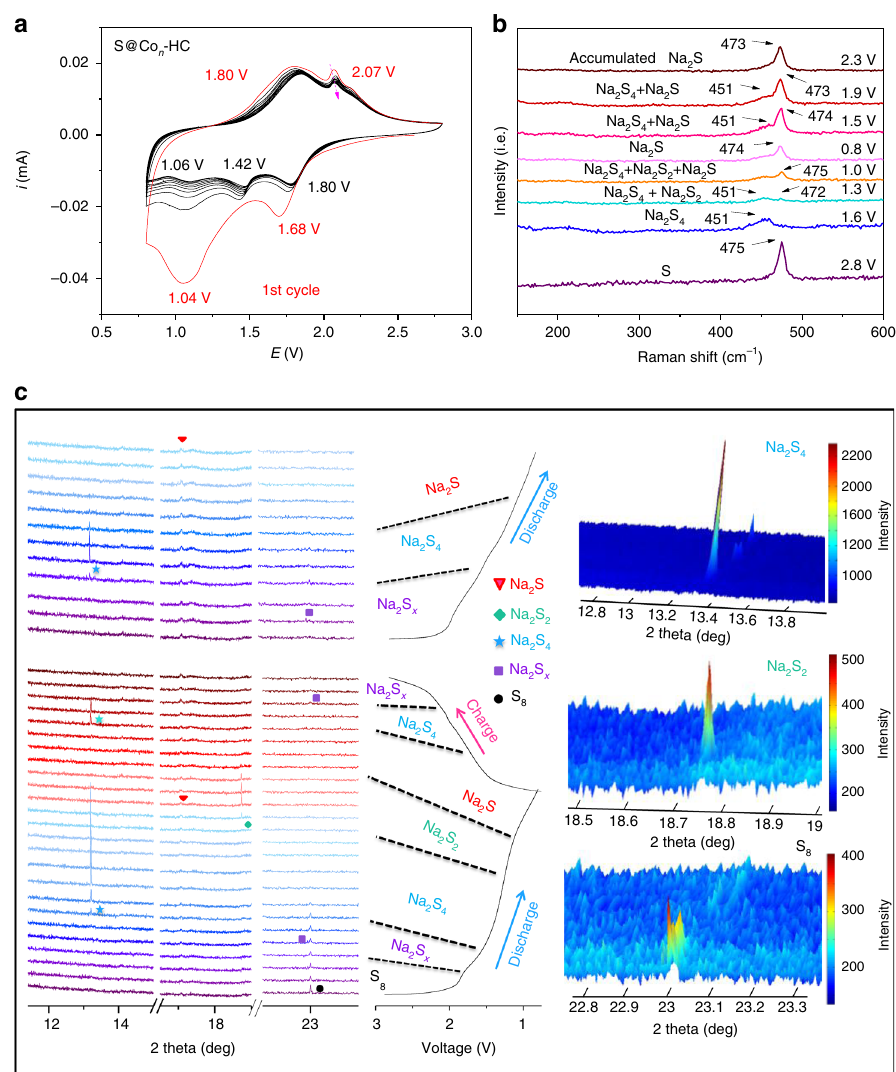
Fig. 5 Characterization of mechanism. a Cyclic voltammograms, and b in situ Raman spectra. c In situ synchrotron X-ray diffraction (XRD) patterns of the room-temperature sodium-sulfur battery comprised of atomic cobalt-decorated hollow carbon sulfur host (RT-Na/S@Co n -HC) cells (left) with the initial galvanostatic charge/discharge curves (middle) at 500 mA g − 1 , and contour plot of XRD patterns at selected ranges of degrees two theta (right)